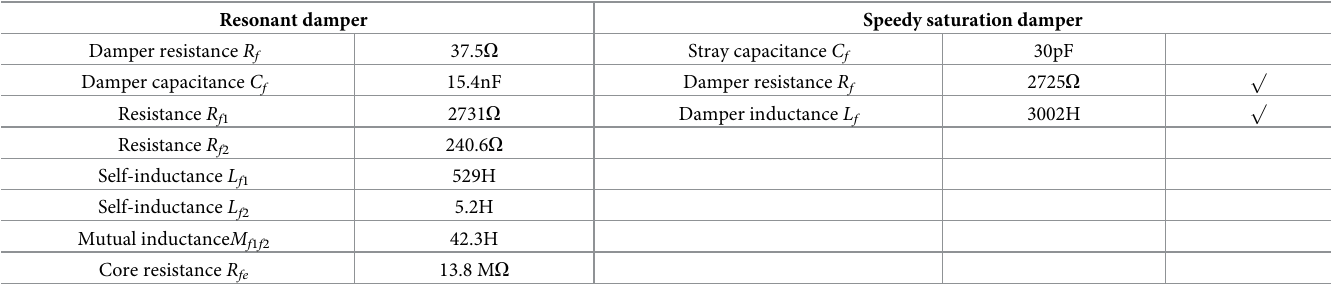
Table 2. Parameter values of the two different dampers.